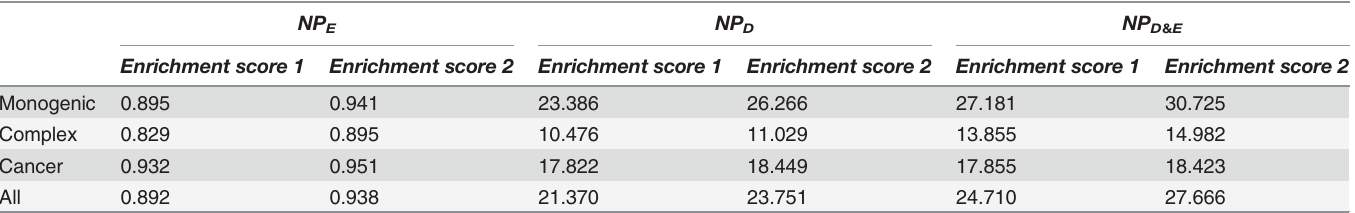
Table 6. Statistics of the performance (the average values of enrichment score) with disease as a unit.